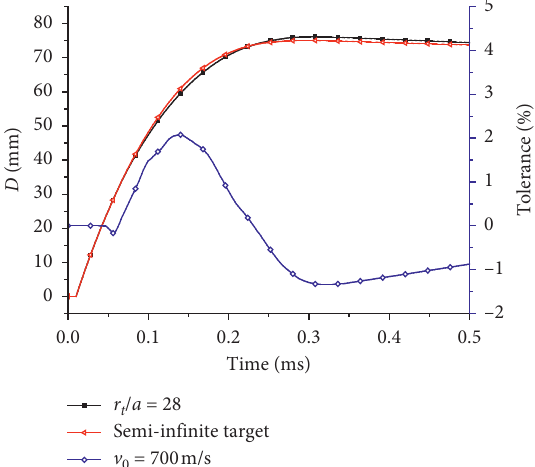
Figure 23: Deviation comparison of the penetration depth for the free boundary ( r t / a � 28) and the nonreflecting boundary ( v � 700m/s).